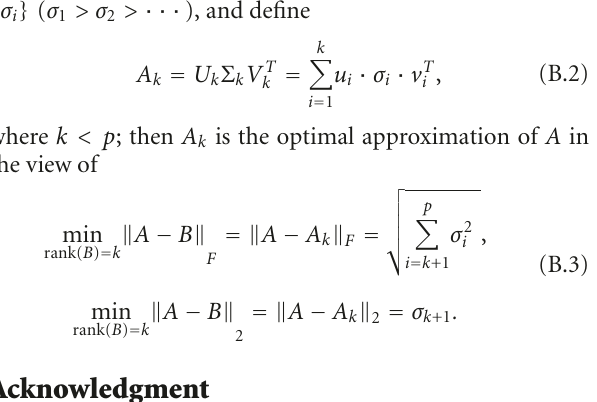
> σ > ··· ). (A.1) is called the Singular Value { σ i } ( σ 1 2 Decomposition (SVD) of A